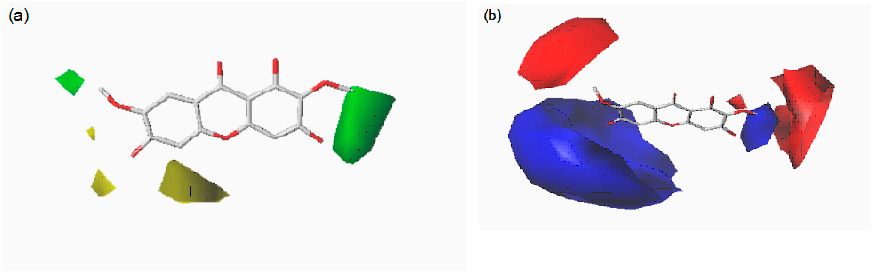
Figure 4. Contour maps of CoMFA: steric ( a ) and electrostatic ( b ) based on Compound 3 .